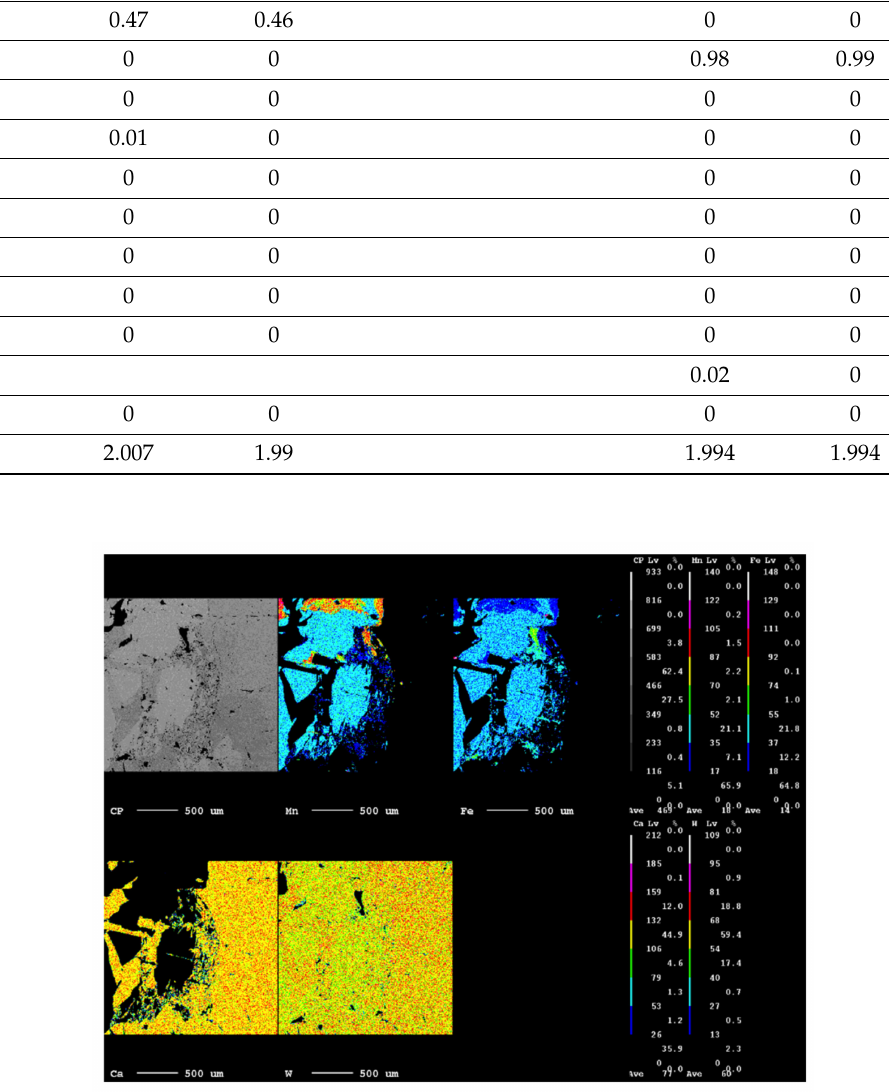
Figure 3. X-ray maps of Fe, Mn, and Ca distribution during wolframite scheelitization. Scheelite . Scheelite (CaWO 4 ) aggregates adjacent to wolframite or Fe,Mn-chlorite were identified. The size of the scheelite aggregates reaches from 1 to 1.5 × 0.5 to 0.75 cm 2 . The color is orange to yellow-brown and fluoresces with a blue-white color, indicating low MoO 3 content (average <0.09%). Traces of Sn, Pb, Bi, and Mo were measured in scheelite by EPMA (Table